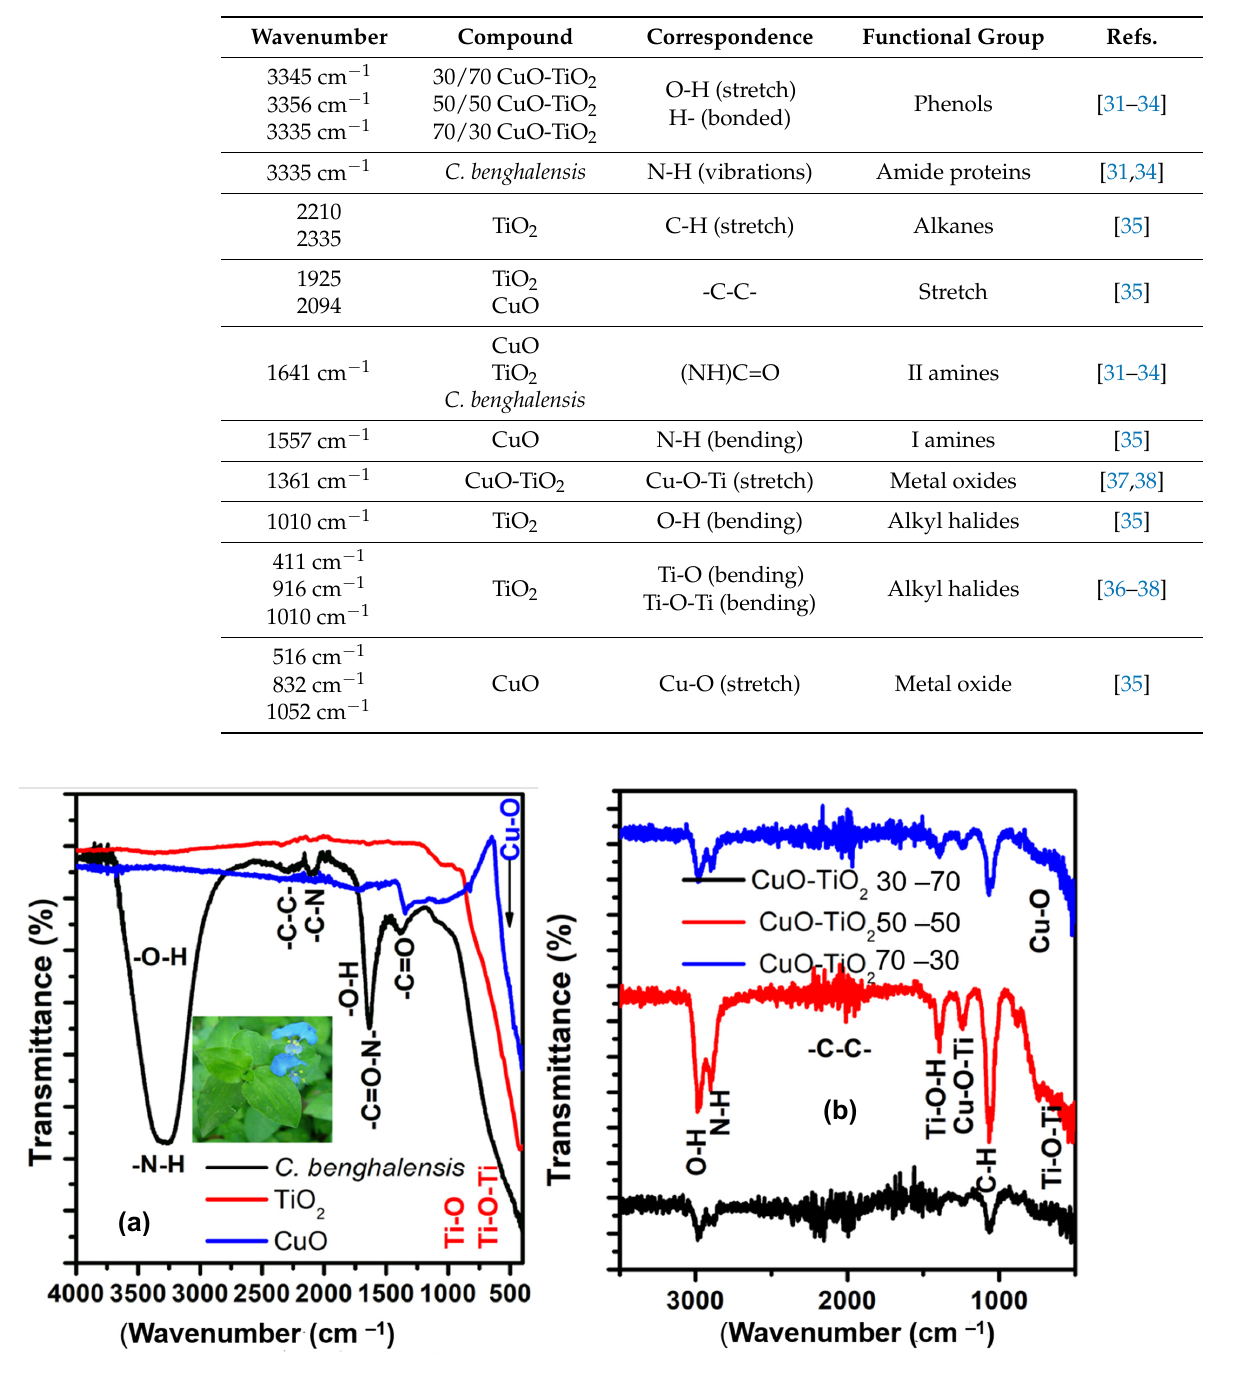
Figure 1. ( a ) FTIR diagram for the C. benghalensis extract, TiO 2 , and CuO and the ( b ) CuO-TiO 2 nano ‐ composites with different compositions.